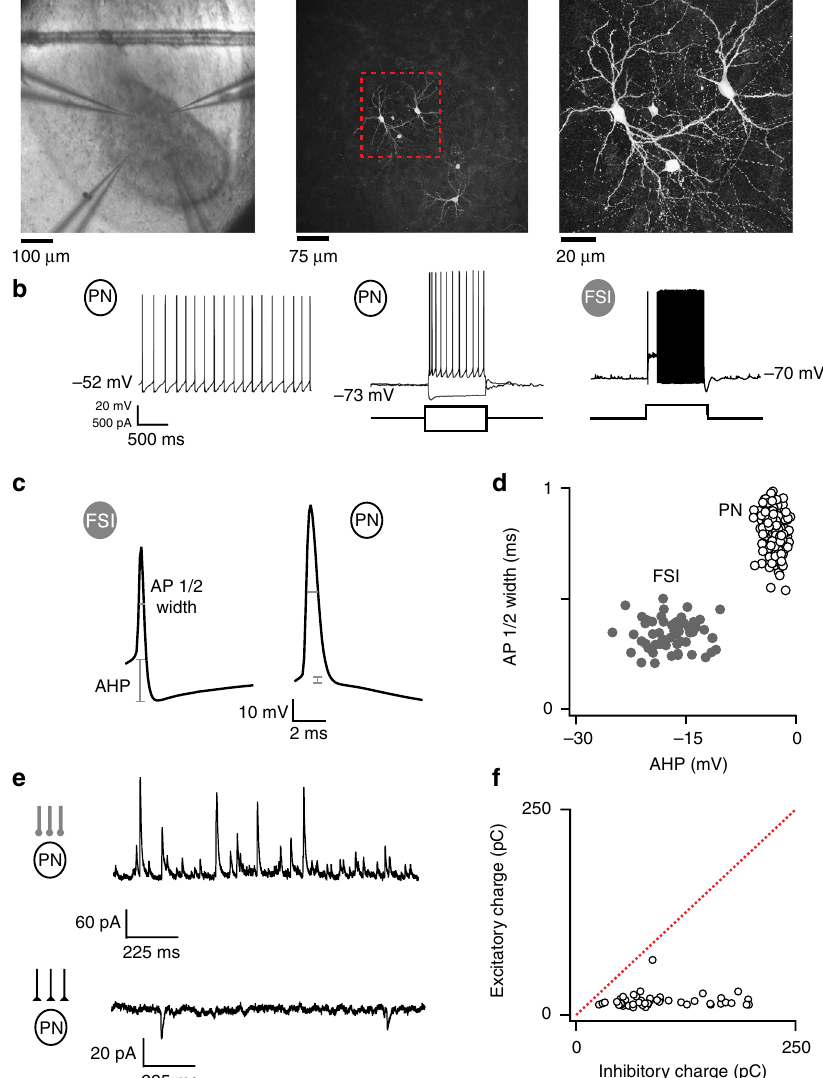
Fig. 1 Inhibition is a major component of RA circuitry. a Micrograph of acute RA slice preparation at three different magni fi cations showing RA with four patch electrodes during whole-cell recording (left), recorded and fi lled neurons visualized in the same slice (middle), and a group of two larger projection neurons (PNs) and two smaller inhibitory fast-spiking interneurons (FSIs, Int) from the middle panel ’ s dotted region (right). PNs and FSIs are morphologically distinct. b PNs and FSIs express distinct fi ring patterns. PNs generate spontaneous tonic pacemaking activity at rest (left). After hyperpolarizing them with DC current, PNs produced adapting trains of high-amplitude ( > 30 mV) action potentials in response to depolarizing current steps, and they expressed voltage sag in response to further hyperpolarization (middle). In contrast, FSIs do not have spontaneous pacemaking activity, and they produce very high-frequency ( > 150 Hz) non-adapting trains of < 30 mV action potentials in response to current injection (right). c Average action potential (AP) waveforms from an FSI (left) and a PN (right). d AHP amplitude and AP width across our sample of FSIs and PNs differentiated these cell types. e Inhibition dominates spontaneous synaptic activity in RA. Example spontaneous inhibitory postsynaptic currents (sIPSCs, top) and excitatory postsynaptic currents (sEPSCs, bottom) recorded from the same PN at equal distance from either E Cl or E AMPAR . Both the frequency and amplitude of sIPSCs are much larger than those of sEPSCs despite the pacemaking activity of other PNs in the circuit. f Average excitatory vs inhibitory charge recorded from 46 PNs demonstrates that inhibition outweighs excitation in RA PNs during spontaneous